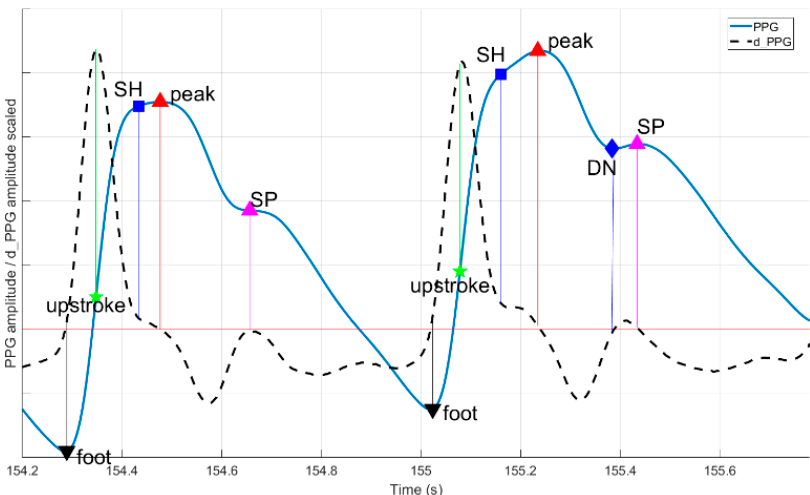
Figure 9. PPG algorithm fiducials’ definition: every beat must have foot, upstroke, and peak, other fiducials may be present depending on exact waveform. DN—dicrotic notch, SH—shoulder, SP—secondary peak.